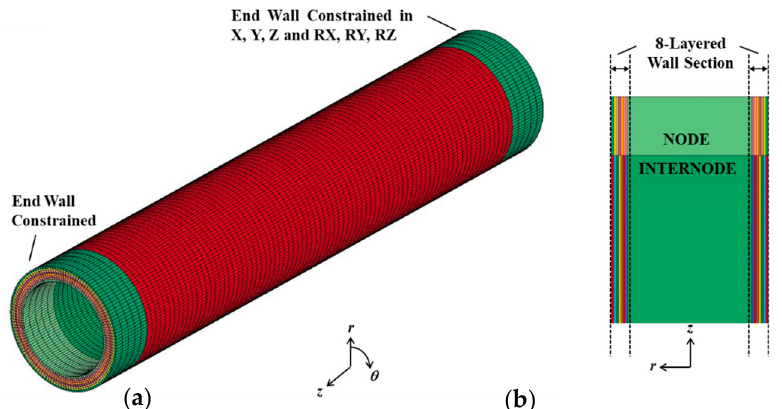
Figure 11. ( a ) Hexahedral mesh solid of internodal unit of bamboo model (number of elements: 89280, number of nodes: 101556) and ( b ) illustration of 8-layered wall section.